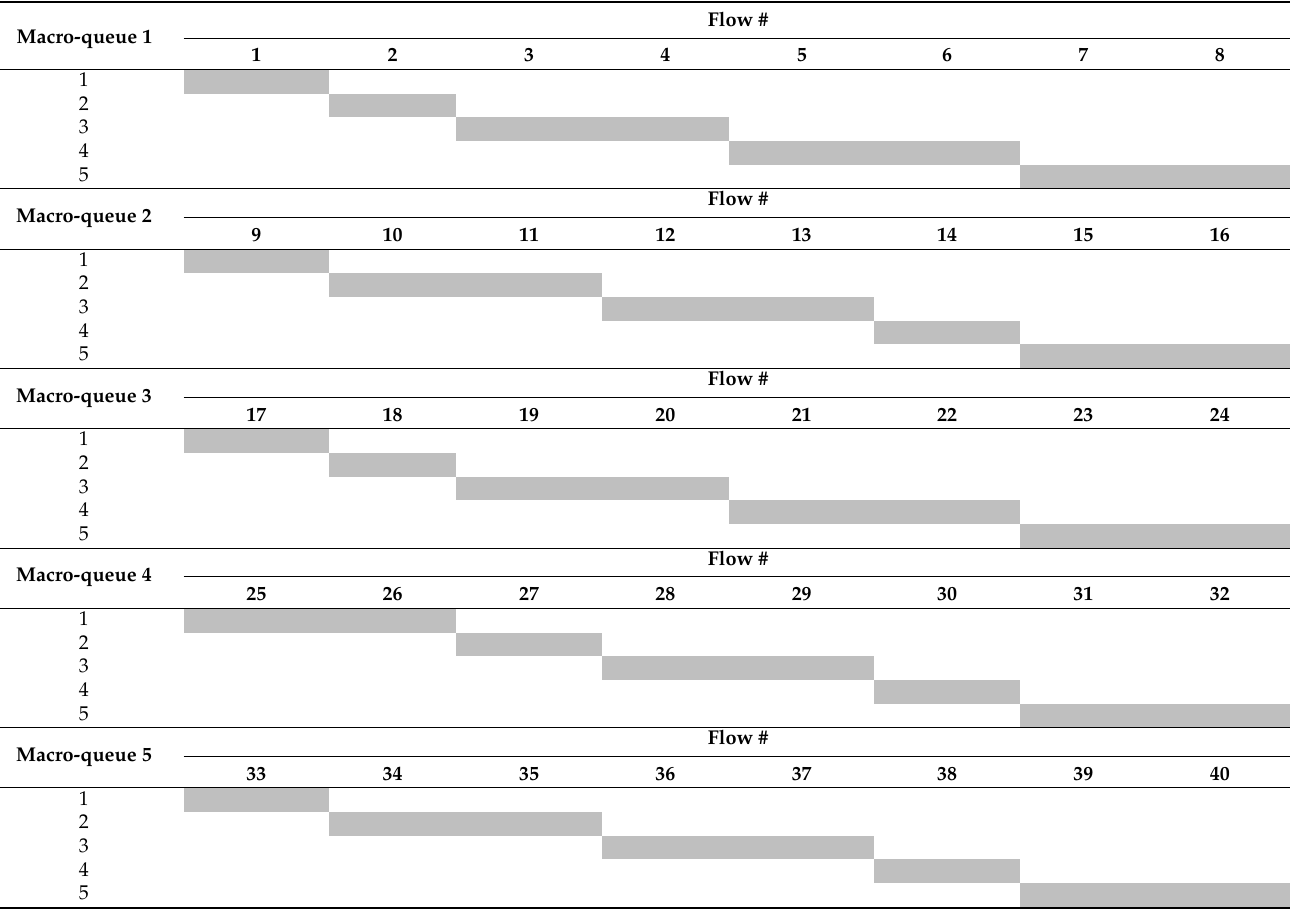
Table 11. The 40 flows’ aggregation and distribution among the sub-queues of five